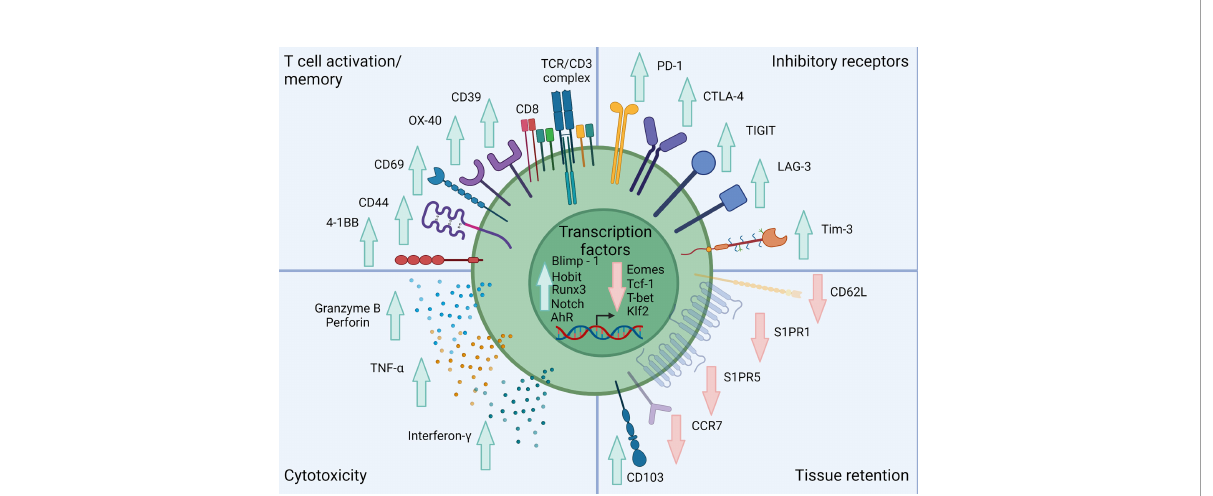
FIGURE 2 Classical phenotype of skin T RM . Skin T RM up regulate markers of memory such as CD44, CD69 and CD103 while down-regulating the lymphoid homing molecule CCR7 and egress receptors CD62L, S1PR1 and S1PR5. Skin T RM also express a range of inhibitory receptors including PD-1, CTLA-4 and LAG-3. These cells also exhibit a unique transcription factor pro fi le exhibited by increased Blimp-1, Hobit, Runx, AhR and Notch expression with inhibition of Eomes, Tcf-1, T-bet and Klf2. They also show a conventional CD8 + T cell cytolytic pro fi le including Granzyme B, Perforin, TNF- a and IFN- g expression. Created with